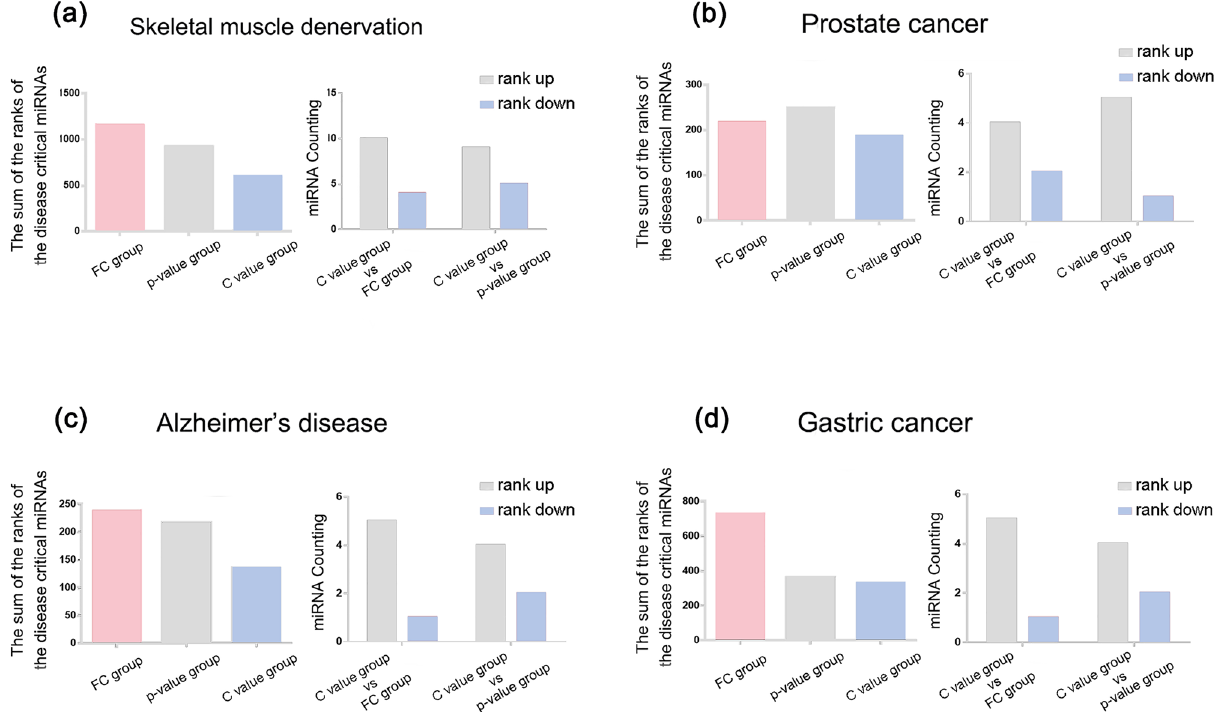
Figure 4. After sorting with C value, the ranking of disease critical miRNAs increased integrally. ( a ) Skeletal muscle denervation. ( b ) Alzheimer’s disease. ( c ) Prostate cancer. ( d ) Gastric cancer. Left: the sum of the ranks of disease critical miRNAs by the three indexes. Right: The number of mRNAs that rank up or down. (FC group: the collection of the top10 FC miRNAs’ predictive target mRNAs; p-value group: the collection of the top10 p-value miRNAs’ predictive target mRNAs; C value group: the collection of the top10 C value miRNAs’ predictive target